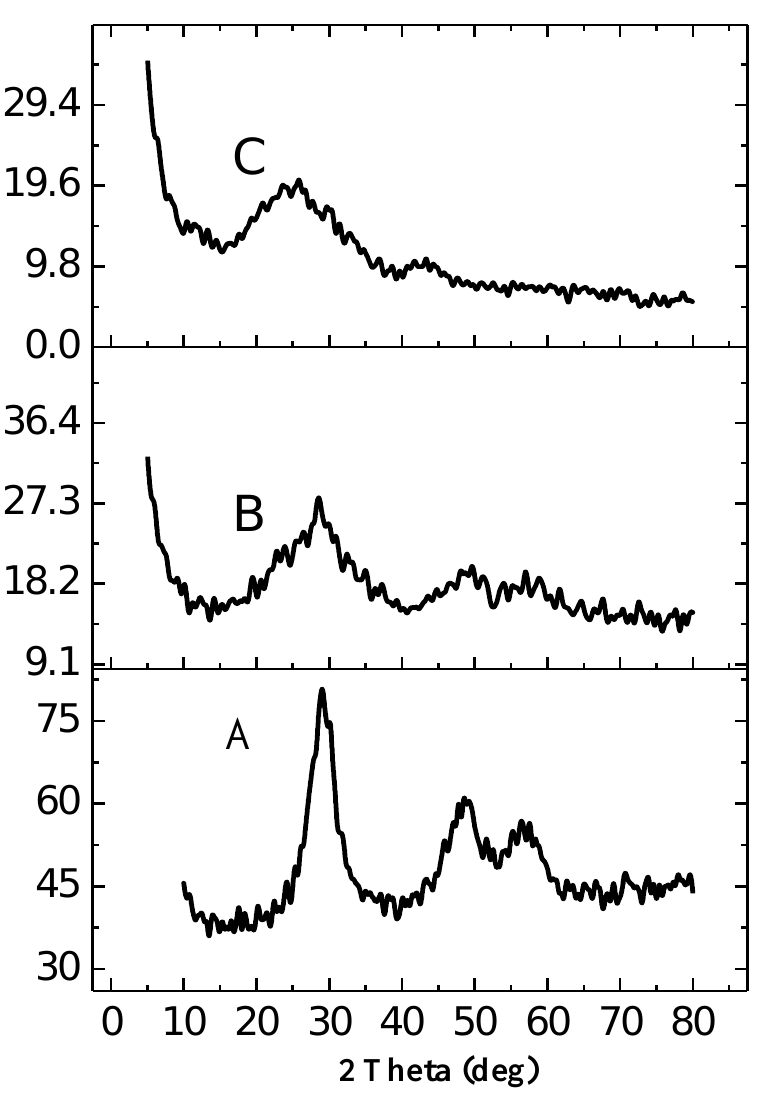
Figure 1. XRD pattern of rGO-ZnS ( A ), rGO-ZnS-Ag ( B ), and rGO ( C ). The TEM images of the rGO-ZnS (Figure 2a,b) sheet-like morphology of the reduced graphene with prominent elevations and depressions can be seen in the TEM images of the synthesized nanocomposites. The ZnS nanoparticles over the reduced graphene surface are somewhat spherical in shape, with varying size. In addition, the nanoparticles are uniformly distributed over the graphene substrate, with an average particle size of 4.91 nm with a lesser degree of agglomeration [28]. The TEM image of rGO is given in Figure S1, which shows a wavey and wrinkle-like pattern. The TEM image of rGO-ZnS-Ag is given in Figure S2, which shows the presence of Ag-doped ZnS on the rGO with block dots.